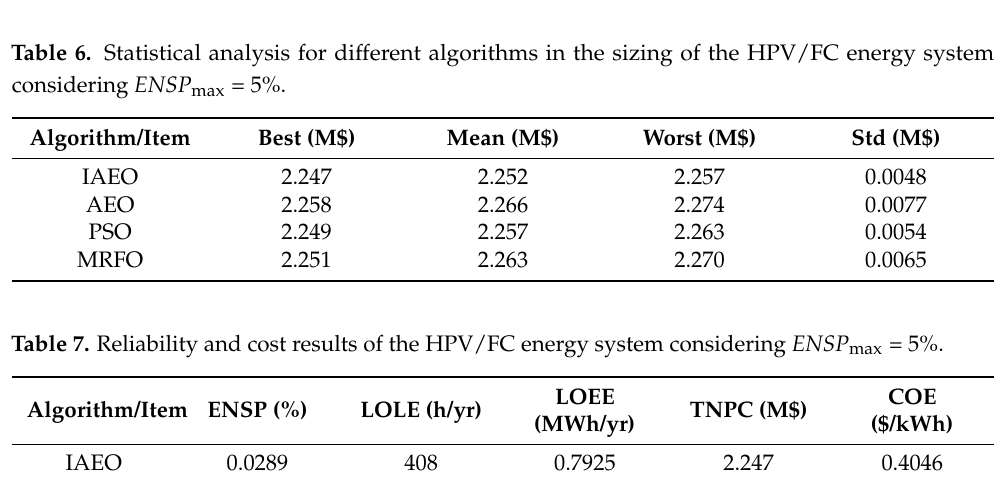
Table 7. Reliability and cost results of the HPV/FC energy system considering ENSP max = 5%.